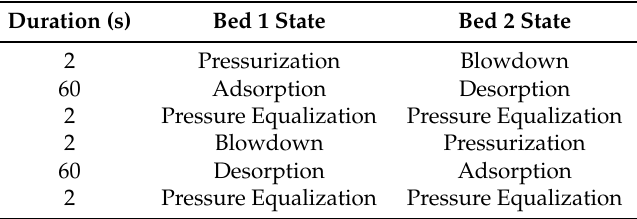
Table 9. Switching strategy for the pressure swing adsorption (PSA) process.